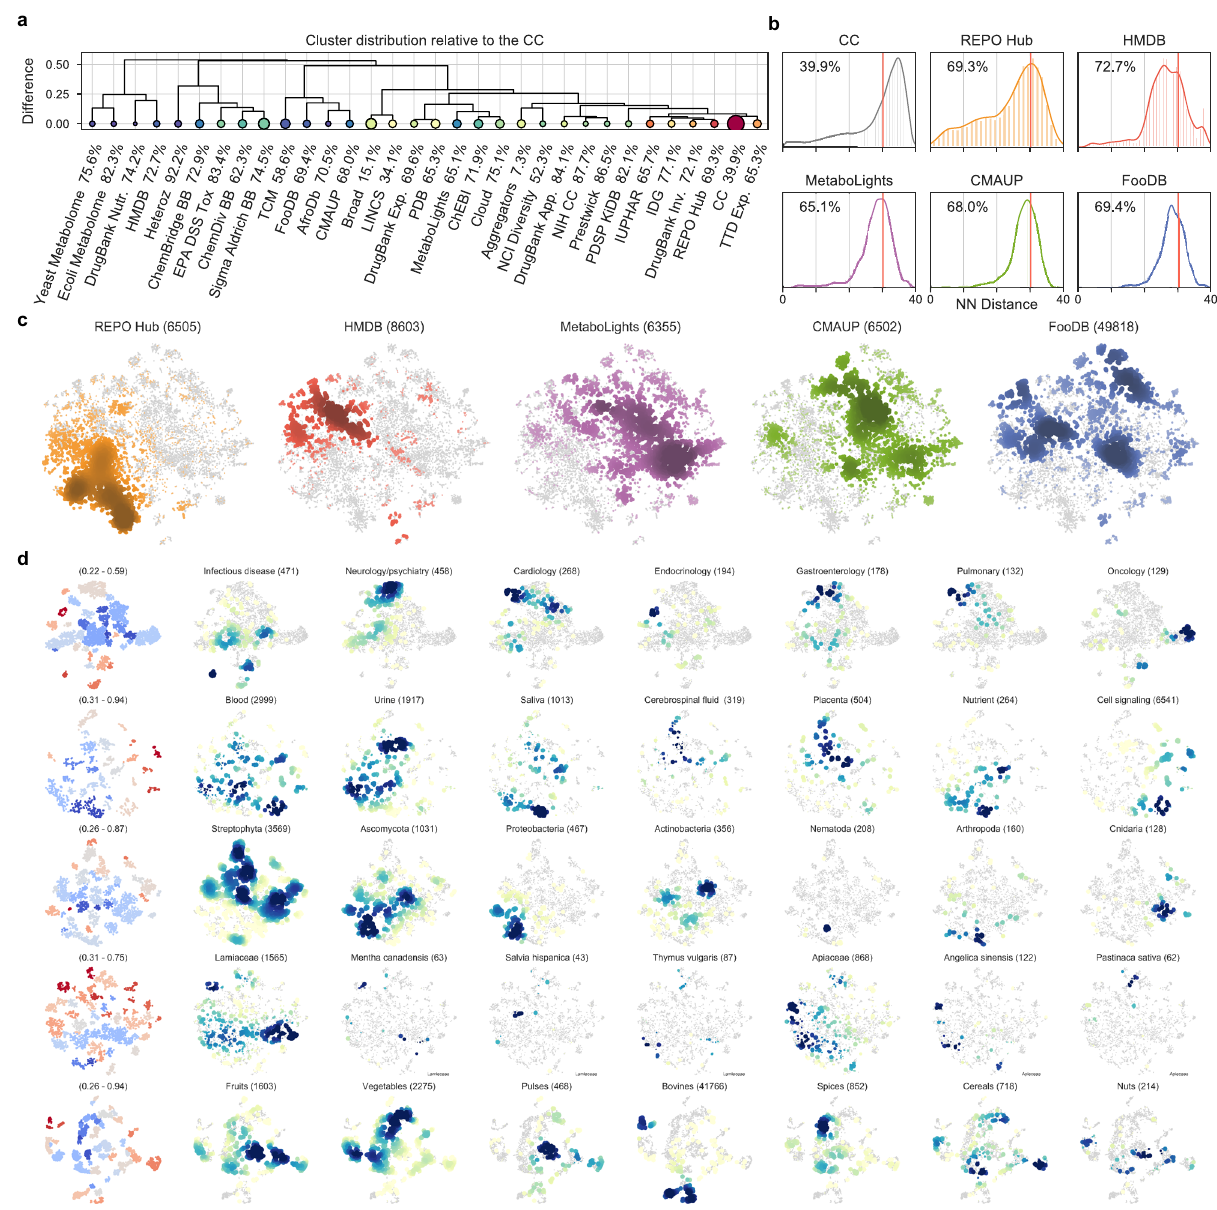
Fig. 3 Signature-based analysis of compound collections. a Chemical libraries are hierarchically clustered by their proximity to the full CC; here, proximity is determined by the cluster occupancy vector relative to the k-means clusters identi fi ed in the CC collection (number of clusters = ( N /2) 1/2 ; GSigs are used). Proximal libraries have small Euclidean distances between their normalized occupancy vectors. Size of the circles is proportional to the number of molecules available in the collection. Color (blue-to-red) indicates the homogeneity (Gini coef fi cient) of the occupancy vectors relative to the CC. b Occupancy of high-applicability regions is further analyzed for fi ve collections (plus the full CC). In particular, we measure the average 10-nearest- neighbor L2-distance (measured in the GSig space) of molecules to the high- α subset of CC molecules (10 3 , Fig. 2). The red line denotes the distance corresponding to an empirical similarity P -value of 0.01. The percentage indicates the number of molecules in the collection having high- α vicinities that are, on average, below the signi fi cance threshold. This percentage is shown for the rest of the libraries in a . c The previous fi ve compound collections are merged and projected together (t-SNE). Each of them is highlighted in a different color with darker color indicating a higher density of molecules. d Detail of the compound collections. The fi rst column shows the chemical diversity of the projections, measured as the average Tanimoto similarity of the 5-nearest neighbors. Blue denotes high diversity and red high structural similarity between neighboring compounds. Coloring is done on a per-cluster basis. The rest of the columns focus on annotated subsets of molecules. Blue indicates high-density